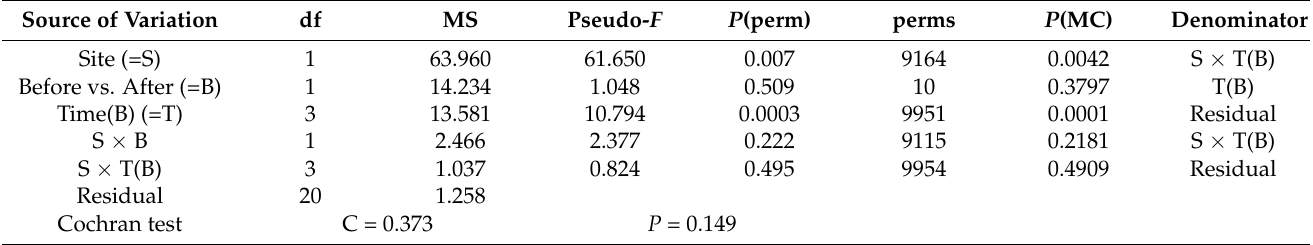
Table 6. PERMANOVA on Margalef’s diversity index ( d ) of benthic assemblages of Treatment and Control sites at Before (T1, T2) and three After (T3–T5) the bioremediating action. Cochran’s C-test was used before each analysis to check for homogeneity of variance.